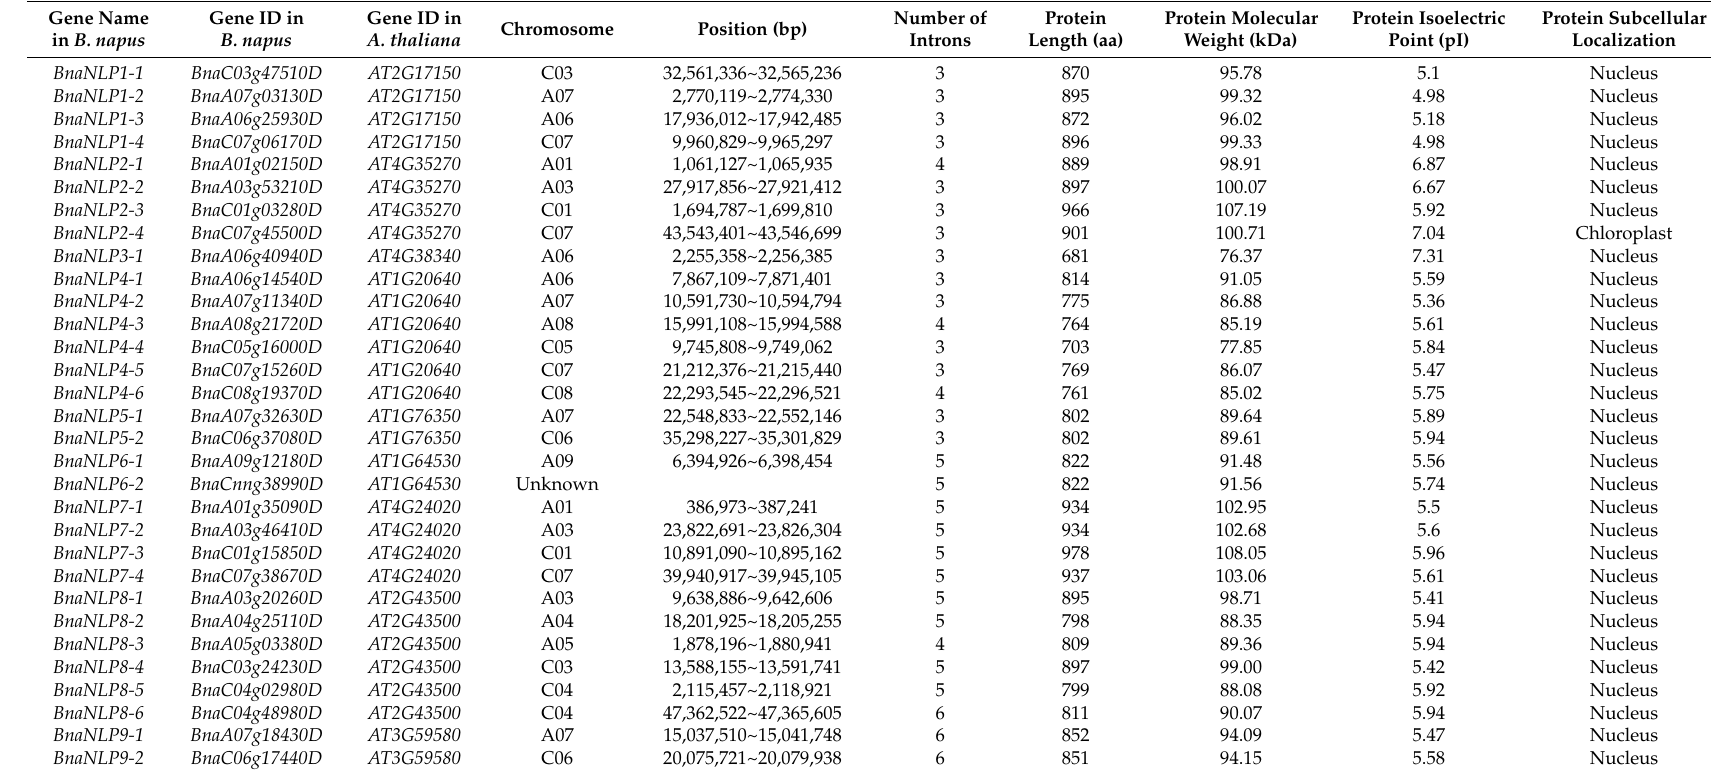
Table 1. List of BnaNLP genes identified in B. napus